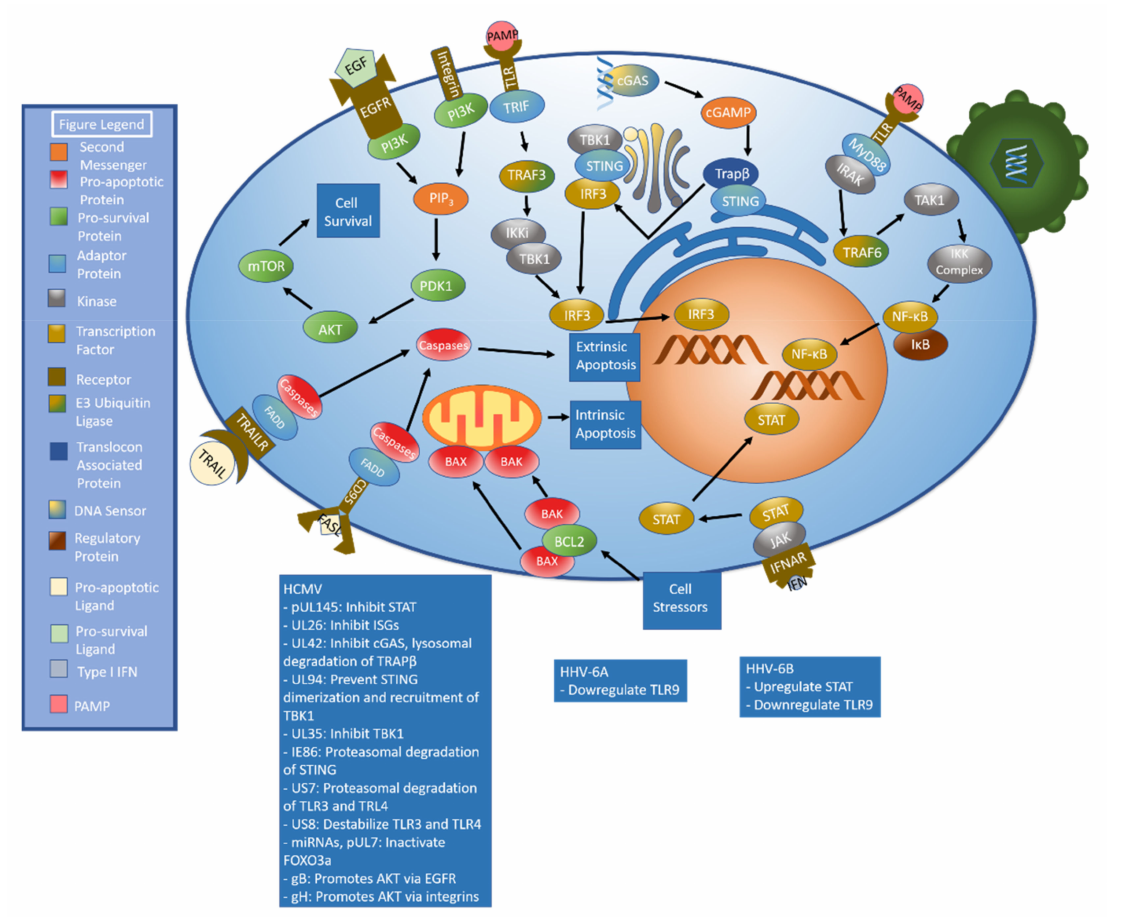
Figure 5. Summary of Key Pathways and Associated Immunoevasive Methods. The immune response to betaherpesviruses begins with the detection of pathogen-associated molecular patterns (PAMPs) by pattern recognition receptors (PRRs), including cGAS and toll-like receptors (TLRs). The cGAS/cGAMP/STING signaling axis results in the production of interferon (IFN) while TLRs can generate both IFN and other defensive compounds. IFN results in STAT activation, which stimulates production of interferon-stimulated genes (ISGs). Betaherpesvirus manipulation of cell survival is an integral element in their success as pathogens. Apoptosis may be stimulated by either intrinsic (BAK/BAX mediated mitochondrial perforation) or extrinsic (FAS ligand/CD95 binding, TRAIL/TRAILR binding) signals. The PI3K/AKT/mTOR signaling pathway represents a major pro-survival cascade. Immunoevasive methods are listed